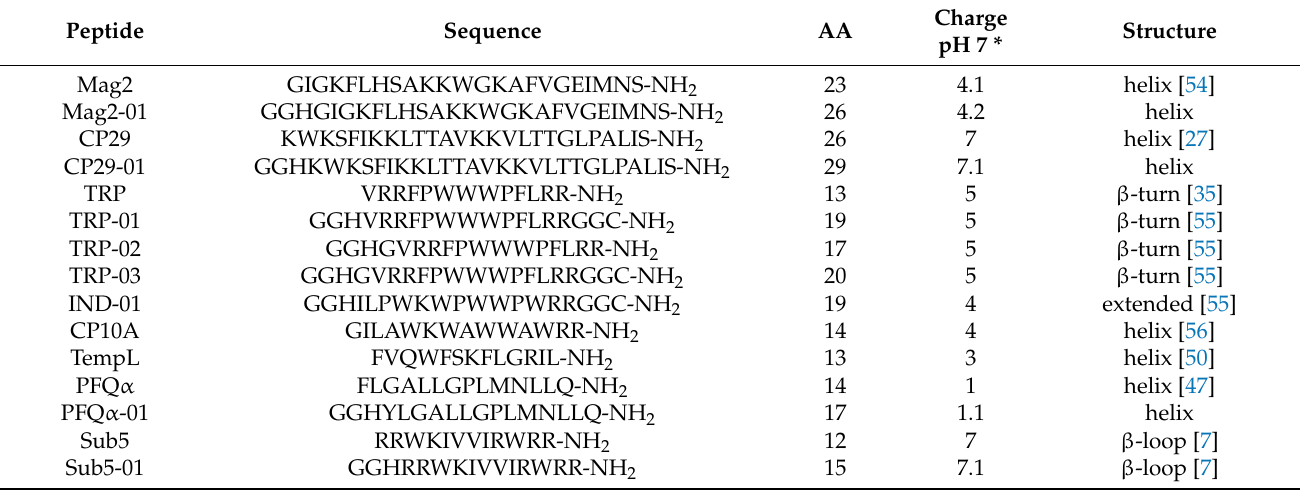
Table 3. Clawed-toe peptides and sequences utilized in this study and others with sequences and defining characteristics. * Estimated charge calculated from Innovagen’s peptide property calculator.